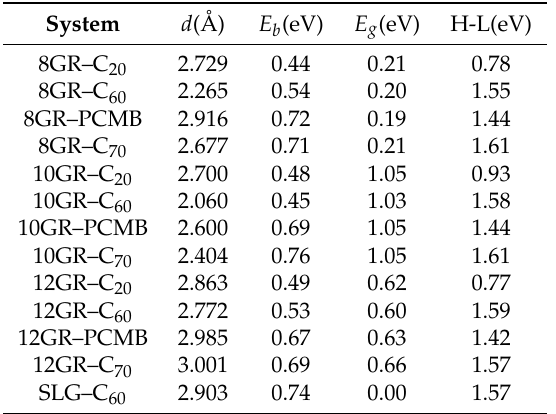
Table 1. Geometrical and electronic parameters of bare fullerenes, pristine graphene and nGRs, and the complexes fullerene–graphene and fullerene–nGR. d is the minimal distance between the components of the complexes, E b is the binding energy, E g the band gap of the nGRs and H-L the HOMO and LUMO of the